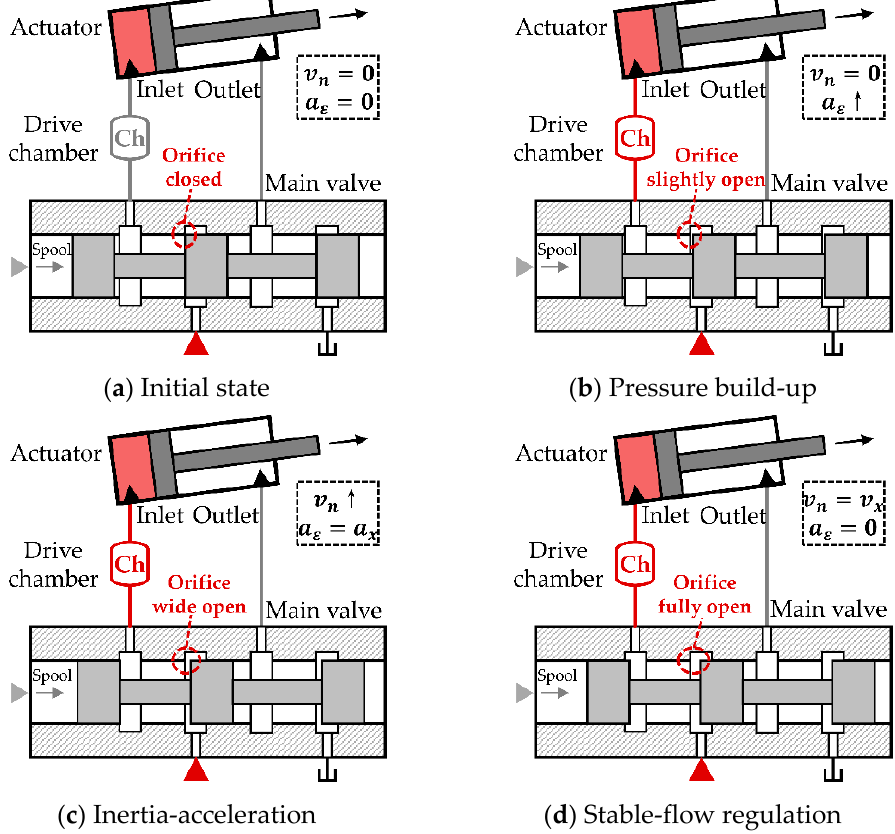
Figure 5. Working conditions of the actuator acceleration process.